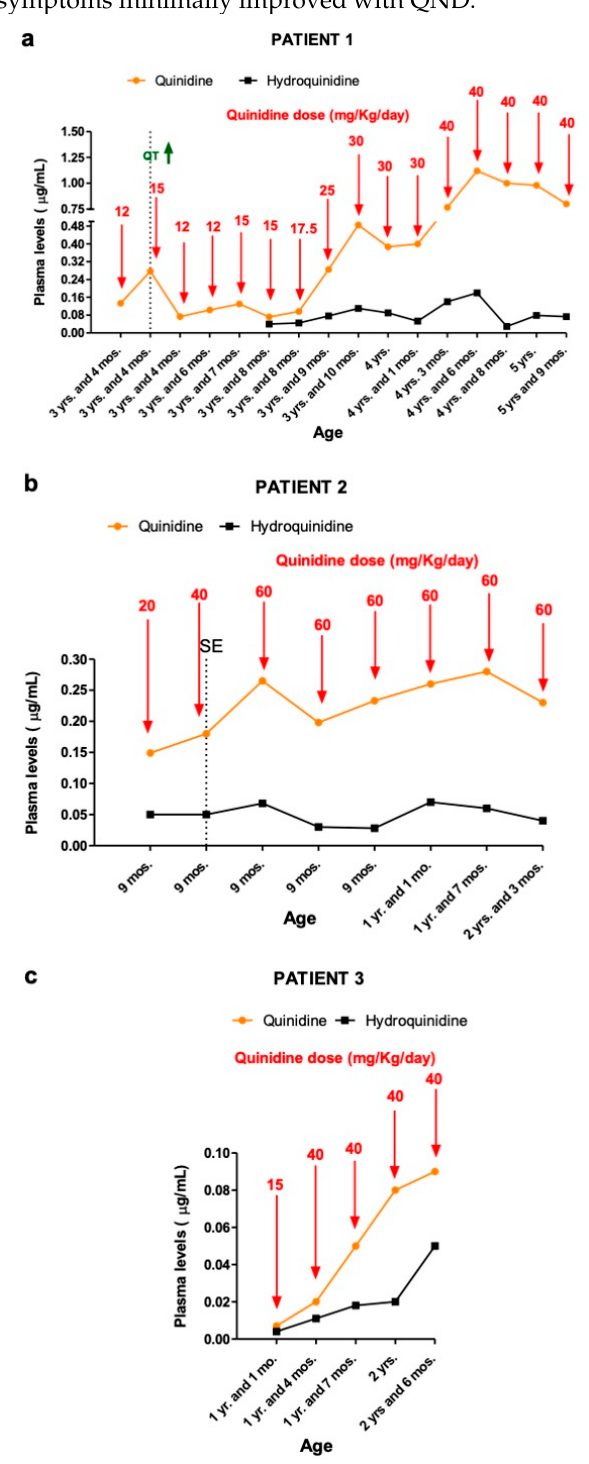
Figure 1. Quinidine and hydroquinidine plasma concentrations in Patient 1 ( a ), Patient 2 ( b ) and Patient 3 ( c ). Abbreviations: SE = Status Epilepticus; yr. = year; yrs. = years; mo. = month; mos. = months. The green arrow indicates the prolongation of QTc interval in the electrocardiogram.